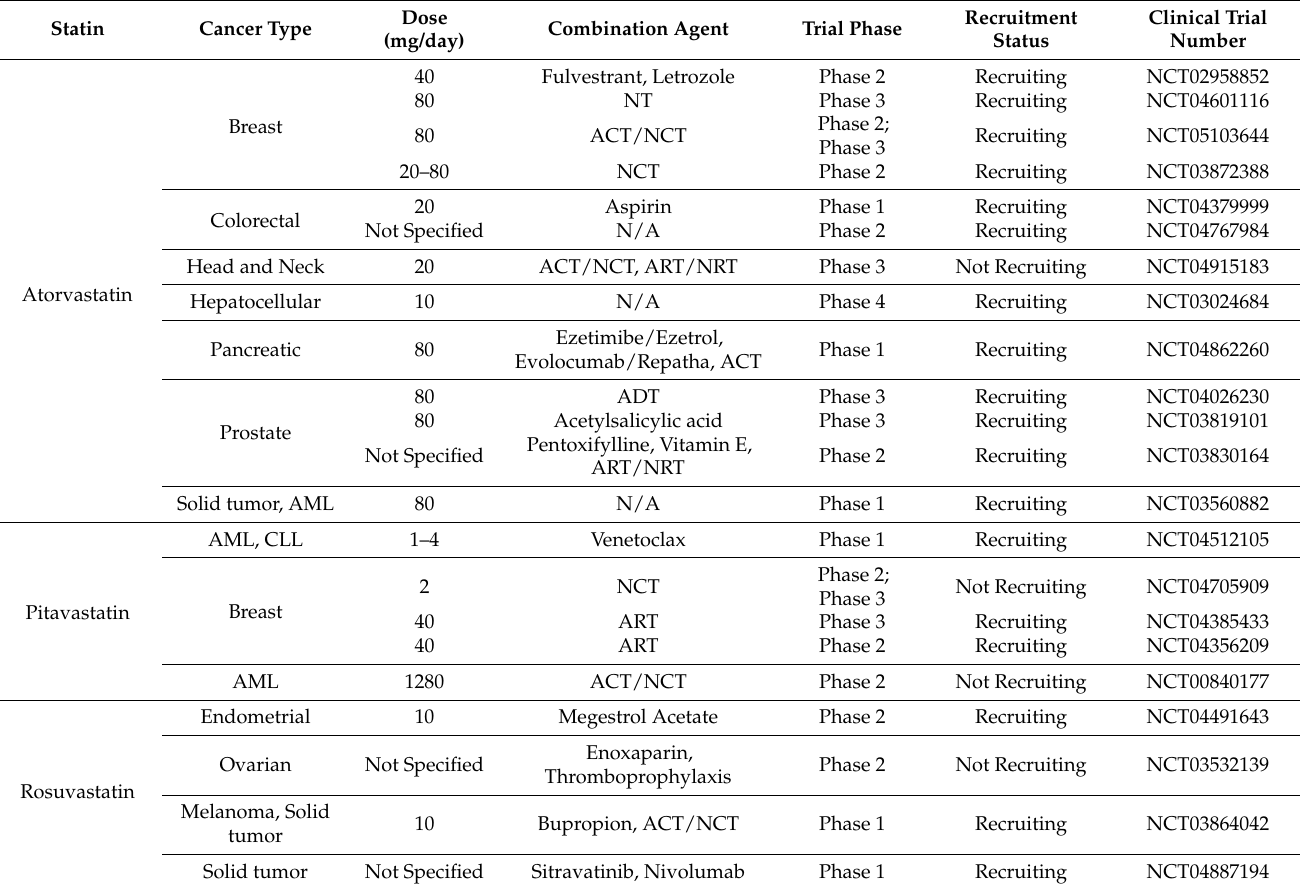
Table 2. Current active clinical trials investigating the effects of statin drugs on various